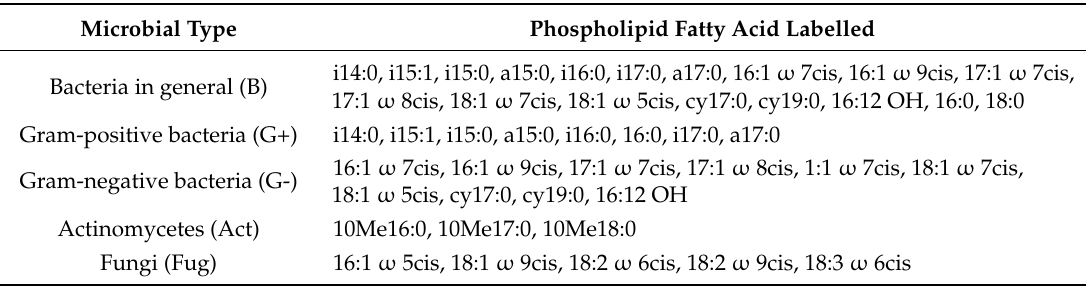
Table 2. Phospholipid fatty acid (PLFA) characterization of